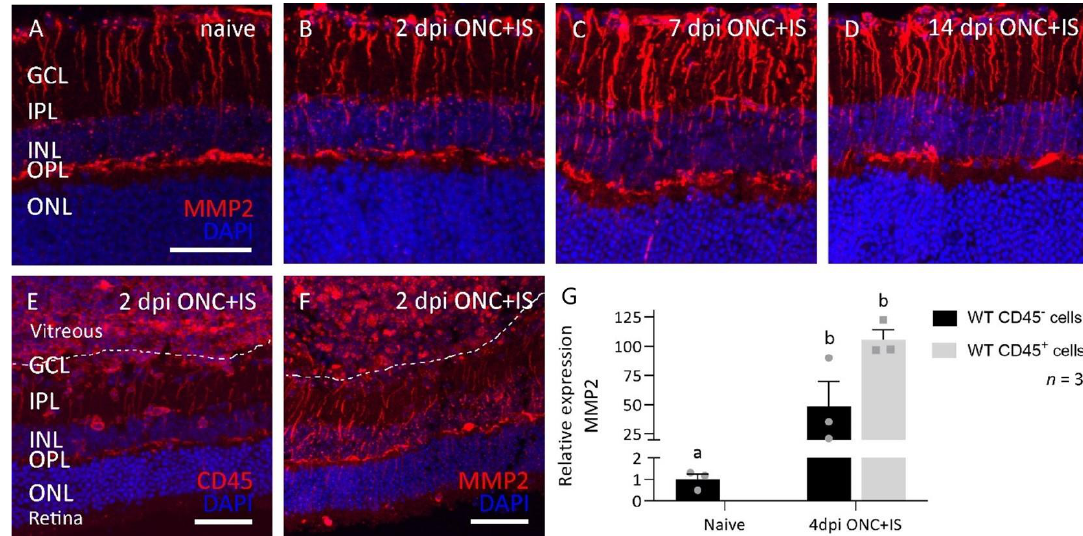
Figure 4. Spatiotemporal expression pattern of MMP2 in the eye of WT mice subjected to the ONC+IS model. ( A – D ) Retinas are dissected at 2, 7 and 14 dpi ONC+IS together with naive retinas. Representative images of MMP2 expression in the Müller glia show an upregulation of MMP2 at 7dpi ONC+IS which goes back to baseline at 14dpi ONC+IS. ( E , F ) Inflammatory stimulation cause an influx of CD45 + cells ( E ) into the vitreous body and retina, which prominently express MMP2 ( F ). Scale bar: 50 µ m, GCL: ganglion cell layer, IPL: inner plexiform layer, INL: inner nuclear layer, OPL: outer plexiform layer, ONL: outer nuclear layer. ( G ) qRT-PCR data showed the expression of MMP2 at 4 dpi ONC+IS in both sorted CD45 - and CD45 + cells. Data are relative expression values compared to the expression value in naive WT CD45 - cells (fold change) and presented as mean ± SEM. Repeated measures two-way ANOVA for qRT-PCR analysis followed by Tukey’s multiple comparisons test. Statistical significance between different time points is indicated using different letters.